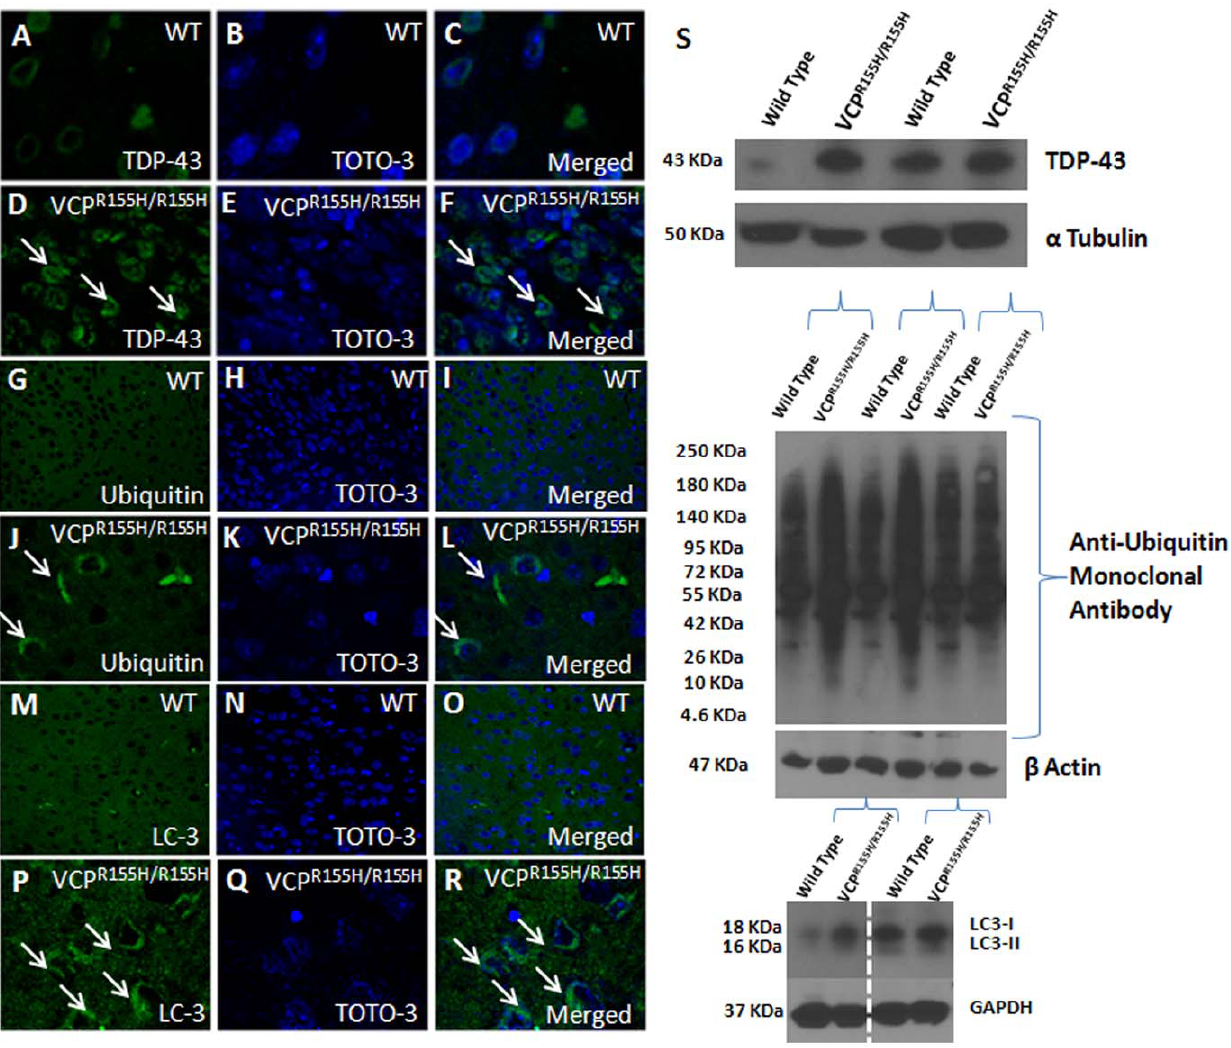
Figure 4. Immunohistochemical and Western blot analyses of TDP-43, ubiquitin, and LC3I/II expression in VCP R155H/R155H and WT brains. TDP-43 expression levels in (A–C) WT and (D–F) VCP R155H/R155H animals. Ubiquitin expression levels in (G–I) WT and (J–L) VCP R155H/R155H animals. LC3I/II expression levels in (M–O) WT and (P–R) VCP R155H/R155H animals. (S) Western blot analyses of TDP-43, ubiquitin and LC3I/II in brains of WT and VCP R155H/R155H animals. Alpha tubulin, b actin, and GAPDH were used as loading